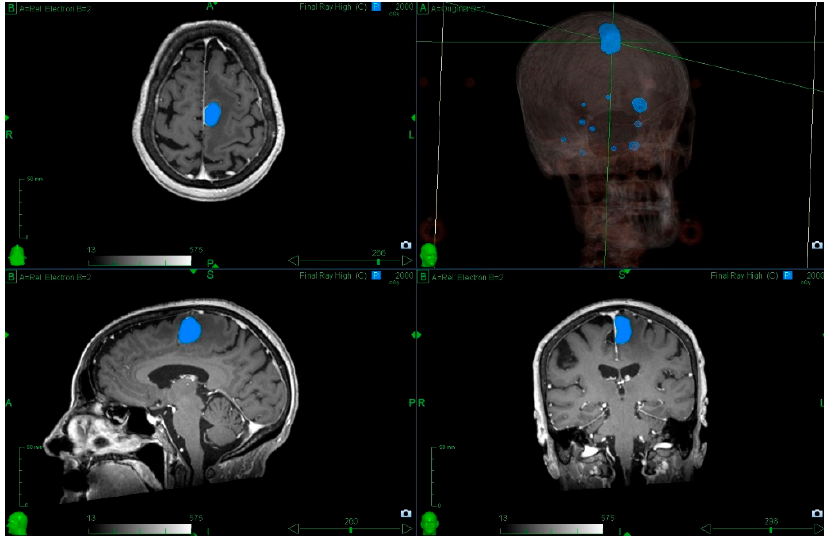
Figure 2. Radiosurgery to multiple metastases. The patient was referred with a symptomatic left frontal lobe metastasis; however, there were 11 metastases in total, and it was possible to treat all within a single session. The blue outline indicates the 20 Gy isodose (minimum dose prescribed to the left frontal lobe metastasis). Prior informed consent has been obtained for use of these images.